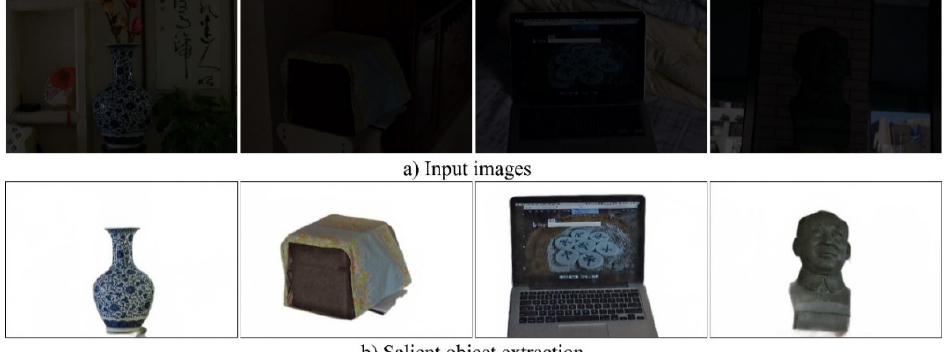
Figure 10. The results of the salient object detection model and binary masking on LOL dataset